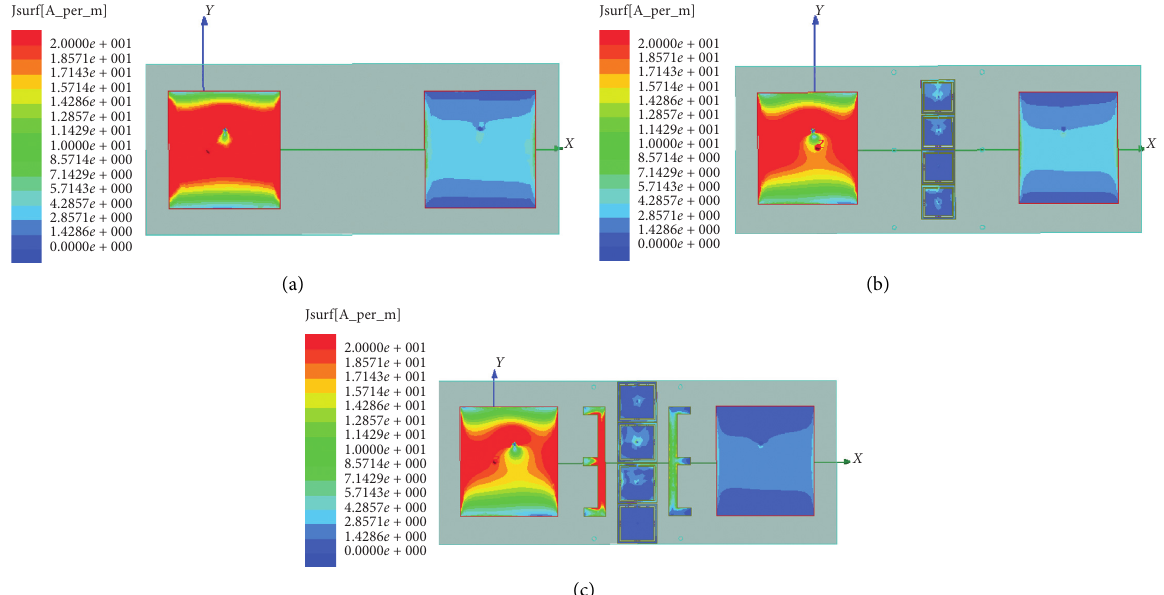
Figure 7: Surface current distribution: (a) AT1; (b) AT2; (c) AT3.